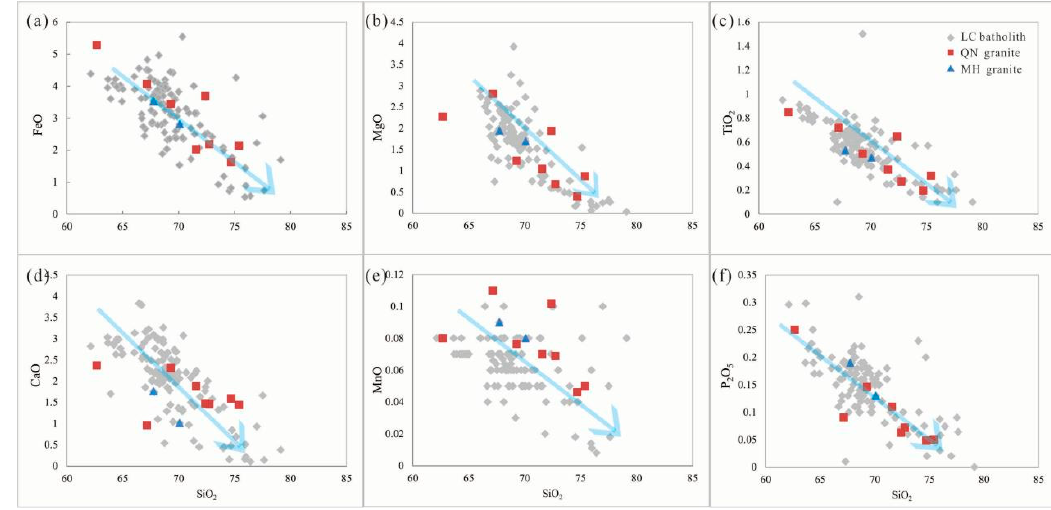
Fig.5 Discrimination diagrams for the genetic types of the Lincang granite Figure 5. Plots of Zr + Nb + Ce + Y versus (Na 2 O + K 2 O) / CaO ( a ), 1000 × Ga / Al versus (Na 2 O + K 2 O) / CaO ( b ) and A(Al—Na—K)-C(Ca)-F(Fe 3 + + Mg) ( c ) for the LC granite (modified from reference [46]).